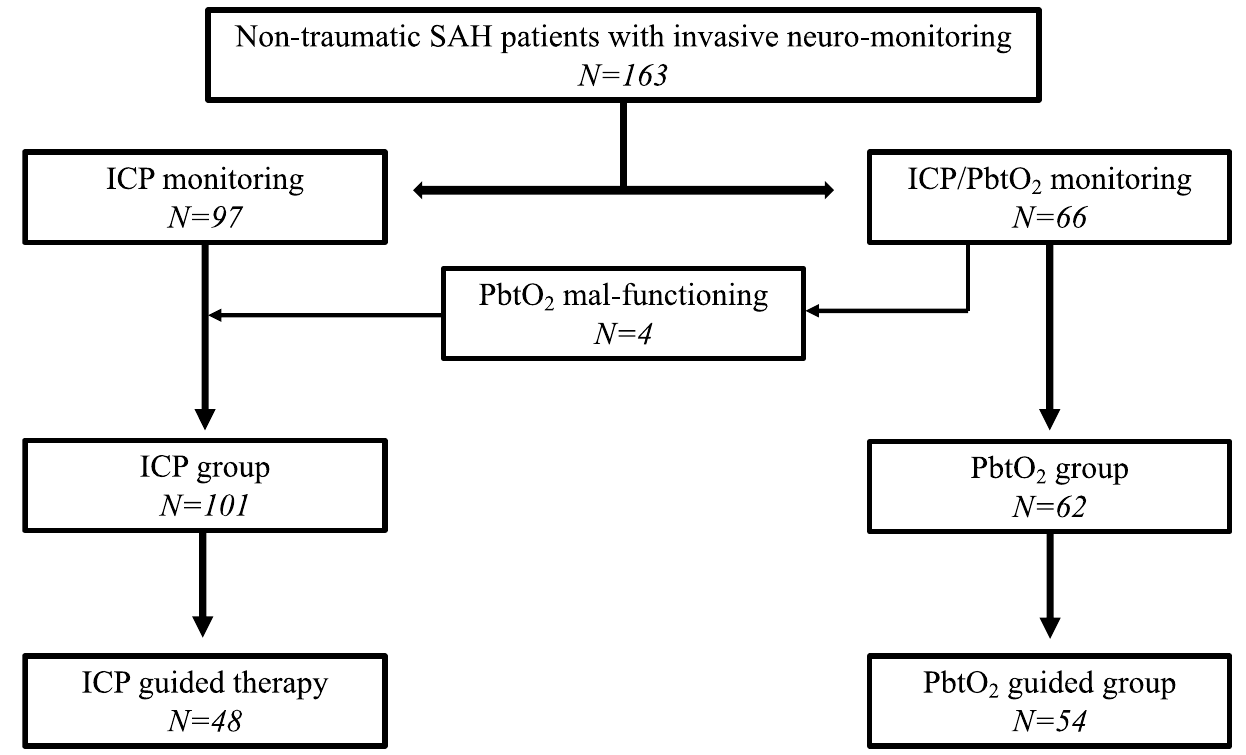
Figure 1. Flow-chart of the study. SAH: subarachnoid hemorrhage; ICP: intracranial pressure; PbtO 2 : brain tissue